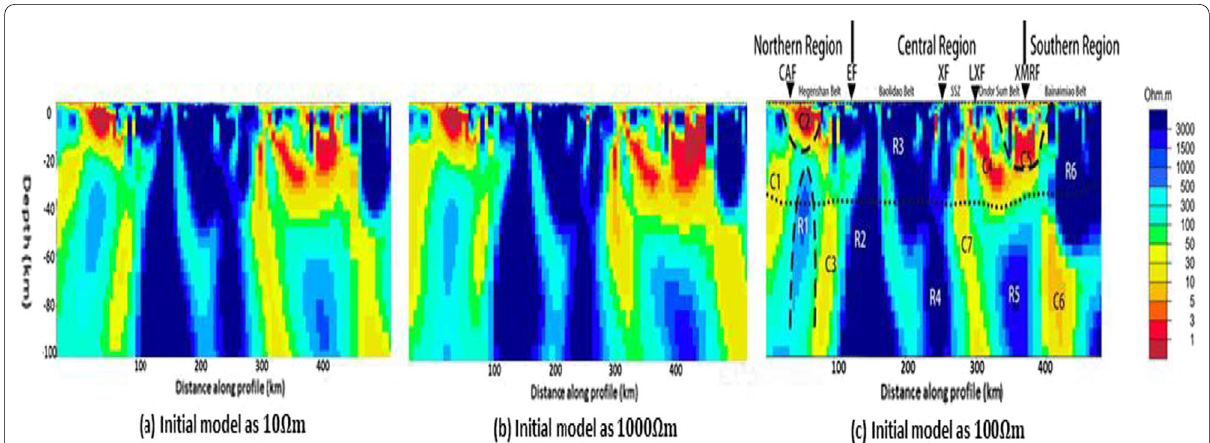
Fig. 9 Sensitivity tests. a – c Inversion results from initial resistivity modelsof 10, and 1000 and 100 (cid:31)